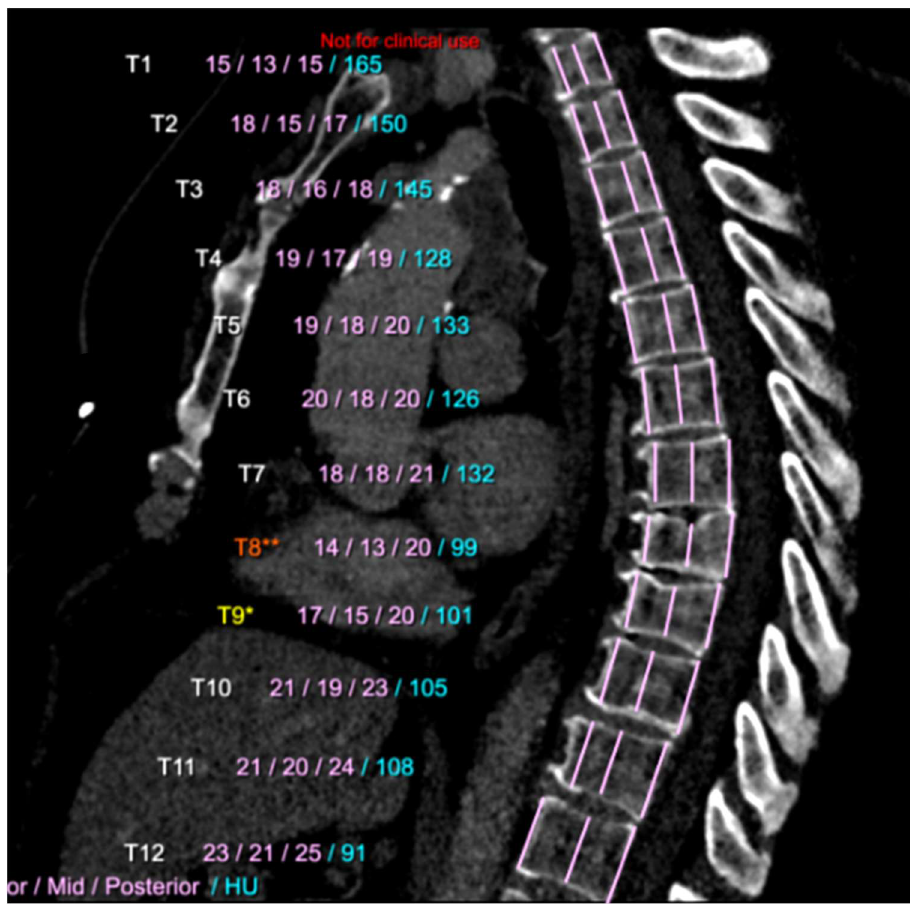
Figure 4. Lateral reconstruction of LDCT images in a COPD patient. Labelling of thoracic vertebra and measures of vertebral bodies heights were automatically obtained through the AI-RAD Companion (Siemens Healthinners, Erlangen, Germany) software. The heights of the T8 and T9 vertebral bodies were lower than those above and below. The bone attenuation values measured within the T8 and T9 vertebral bodies were also lower than those above and below (osteoporosis and minimal collapse of the T8 vertebral body).